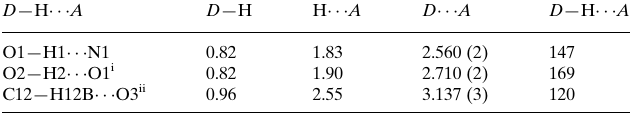
Hydrogen-bond geometry (A˚ , (cid:2)